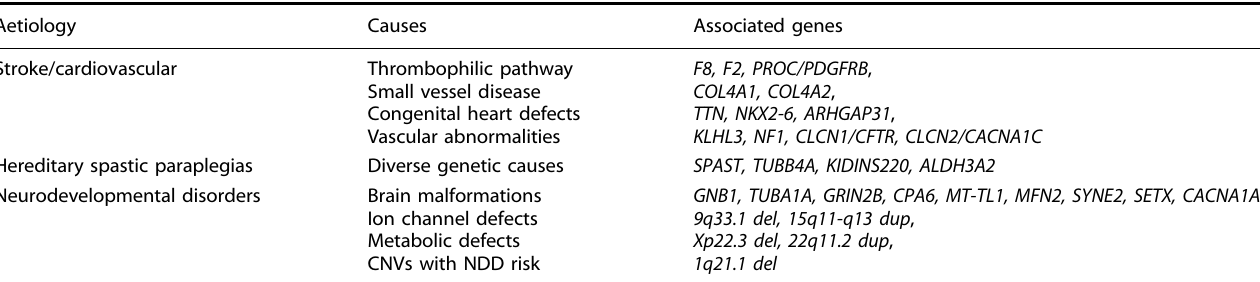
Table 3. Aetiological sub-types of genetic cerebral palsy identi fi ed in this study.